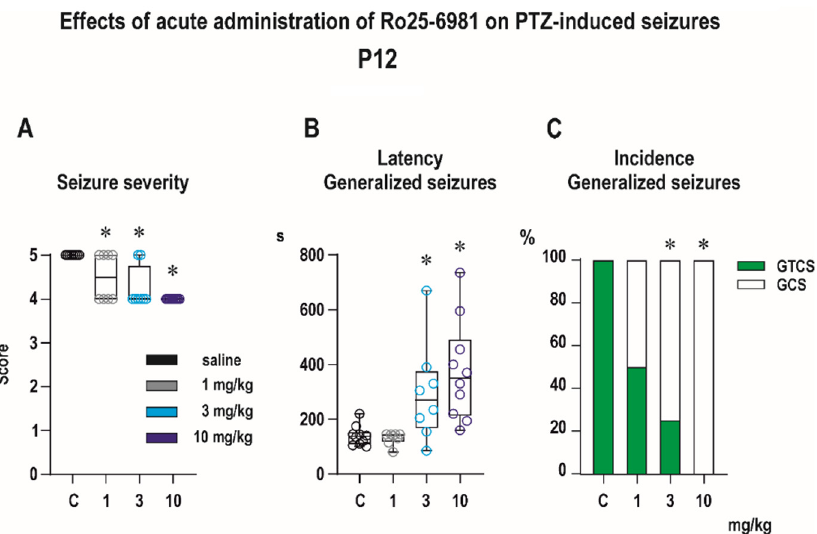
Figure 4. Effects of Ro 25-6981 on pentylenetetrazole (PTZ)-elicited seizures in P12 pups (experimental groups consisted of 8–10 animals). ( A ) Ro 25-6981 in all tested doses significantly decreased the seizure severity expressed as a score ( y axis). This effect was driven mainly by suppressing the tonic phase (TF) of generalized seizures (GS). ( B ) Administration of Ro 25-6981 in doses 3 and 10 mg/kg i.p. significantly extended latencies (in seconds, y axis) to GS onset. ( C ) In the highest dose of 10 mg/kg Ro 25-6981 completely abolished TF, but the total incidence of GS was not affected by pretreatment with Ro 25-6981 in any tested dose. The percentage of animals exhibiting complete generalized tonic–clonic seizures (green) and generalized seizures without tonic phase, i.e., generalized clonic seizures (white) is on the y axis. Asterisks denote a significant difference in comparison with the controls. The x axis in all three graphs presents the control and three groups with different doses (1, 3, and 10 mg/kg) of Ro 25-6981. Data in graphs ( A , B ) are presented as box plots (the sample median and the first and third quartiles) with whiskers (min and max). Circles mark individual values. Asterisk denotes significant difference compared to